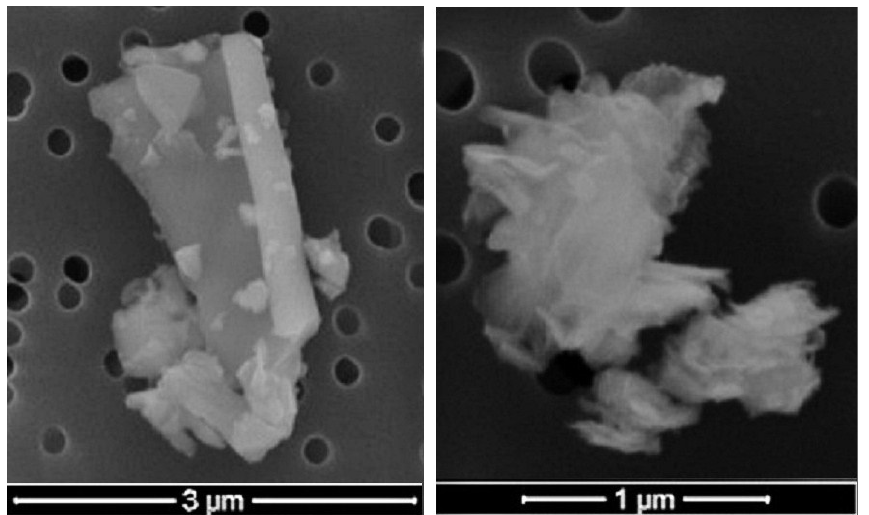
Fig. 4. ESEM images of two ash particles from the Eyjafjallaj¨okull (sample name: EY01): examples for different particle surface structures.